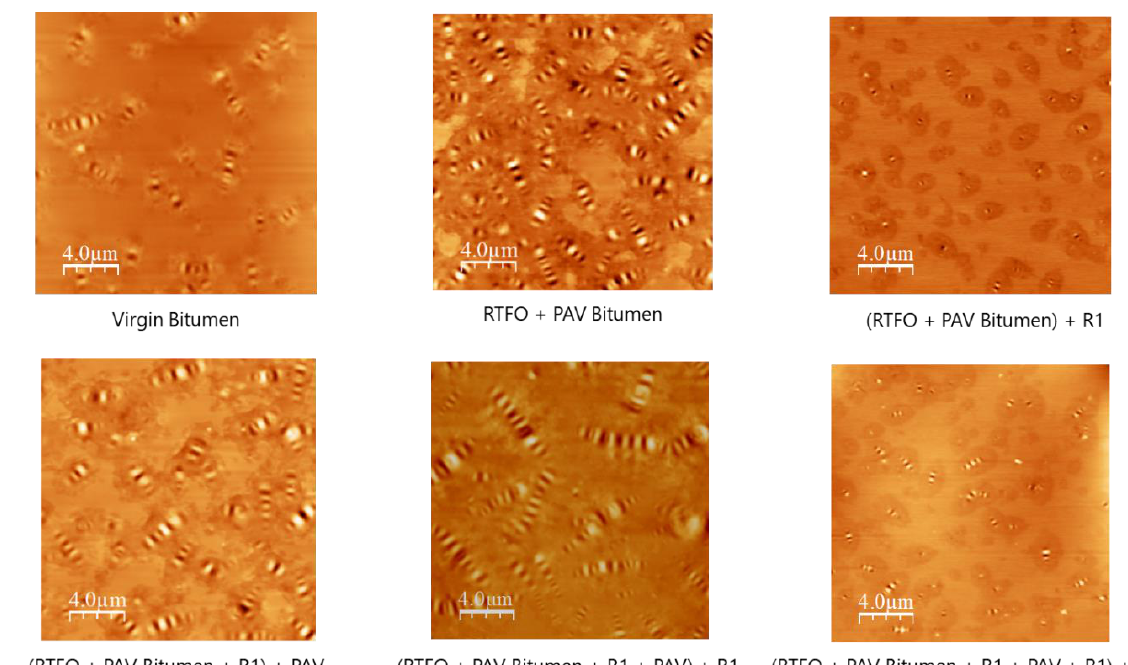
Figure 3. AFM images of virgin, aged, and R1-modified samples.